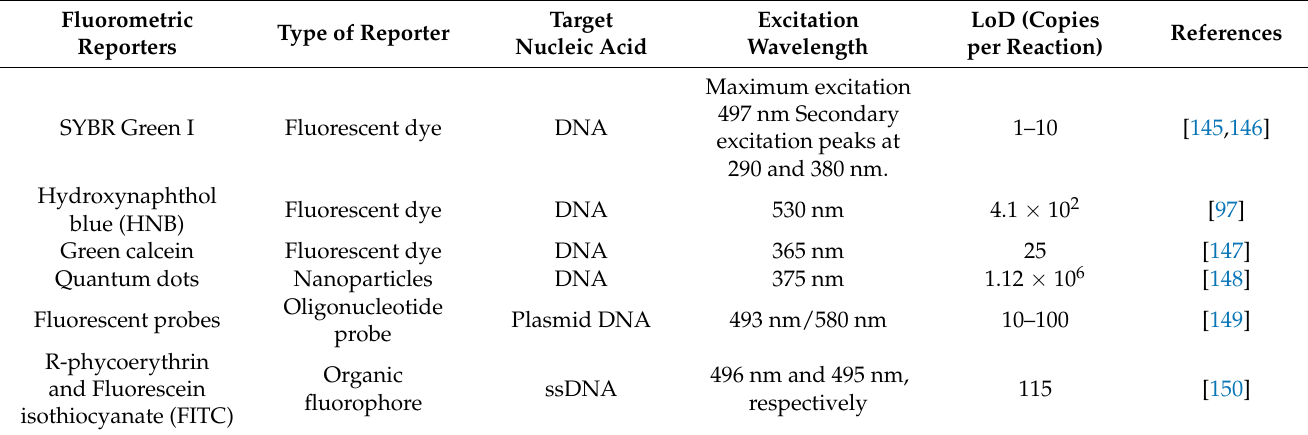
Table 1. Summary of fluorometric reporters and their